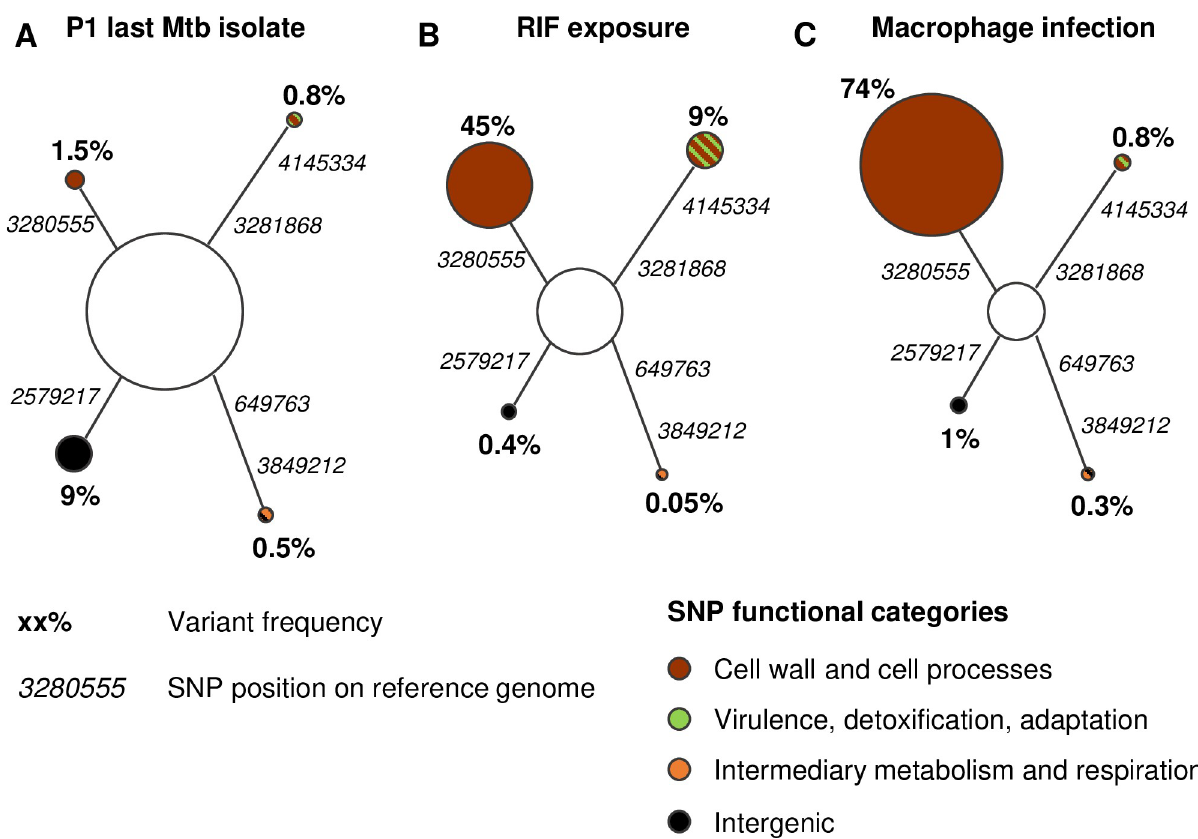
Fig 2. A minor variant of Mtb clinical isolate is selected in response to both rifampicin (RIF) exposure and macrophage infection. Minimum spanning trees (MST) of (A) the last Mtb isolate of P1 patient, (B) after in vitro RIF exposure or (C) after 7 days of macrophage infection, assessed by targeted NGS with coverage ranging from 10 000 to 36 000x. (B) After 4 weeks of in vitro RIF exposure at 1x minimum inhibitory concentration (MIC) in MGIT, bacteria were plated and then sequenced. (C) Macrophages were infected by the last isolate of P1 patient at a multiplicity of infection (MOI) of 10:1 (bacteria:cells). At 7 days post-infection, macrophages were lysed to recover, plate and then sequence intracellular bacteria. All experiments were performed at least twice, and MST are pooled results of these independent